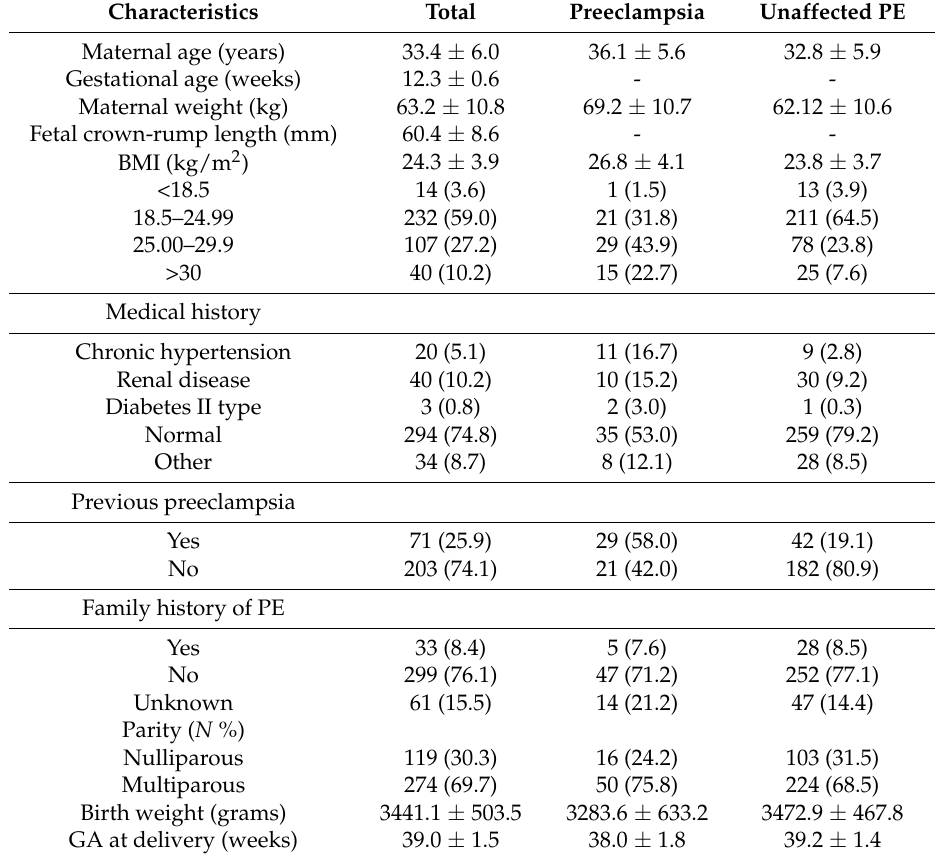
Table 1. Maternal characteristics in the screening population. Mean ± SD, N (%).